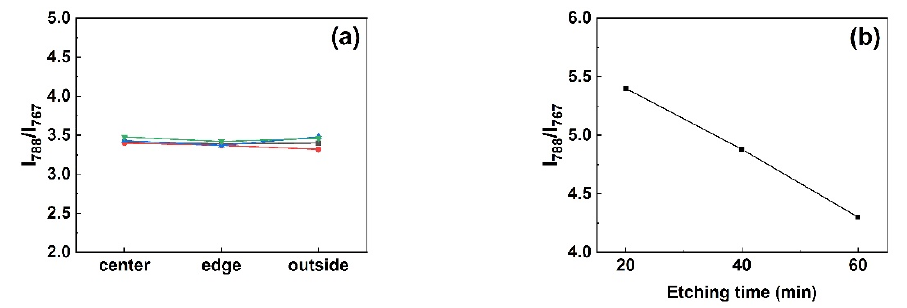
Figure 13. ( a ) Intensity ratio of the peak at − 788 cm − 1 and the peak at − 767 cm − 1 at different positions in unetched micropipes; ( b ) change in the intensity ratio of the peak at − 788 cm − 1 and the peak at − 767 cm − 1 with etching time.